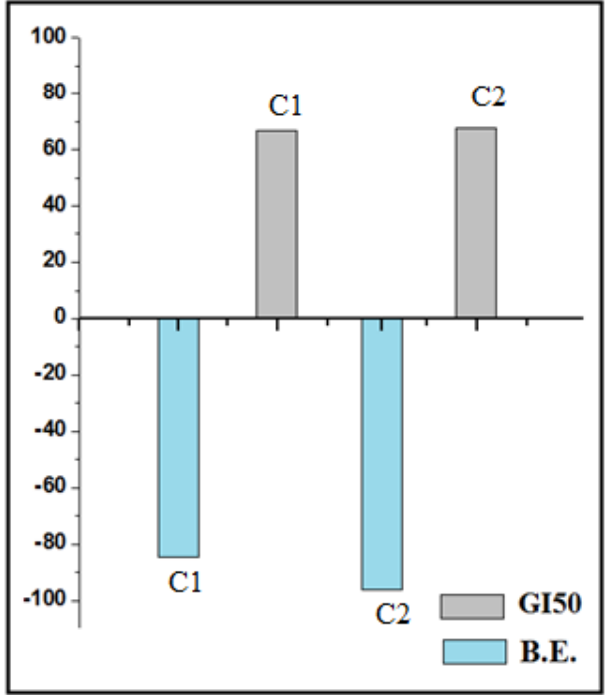
Figure 5. Correlation plot of binding energy and GI50 for C 1 and C 2 .